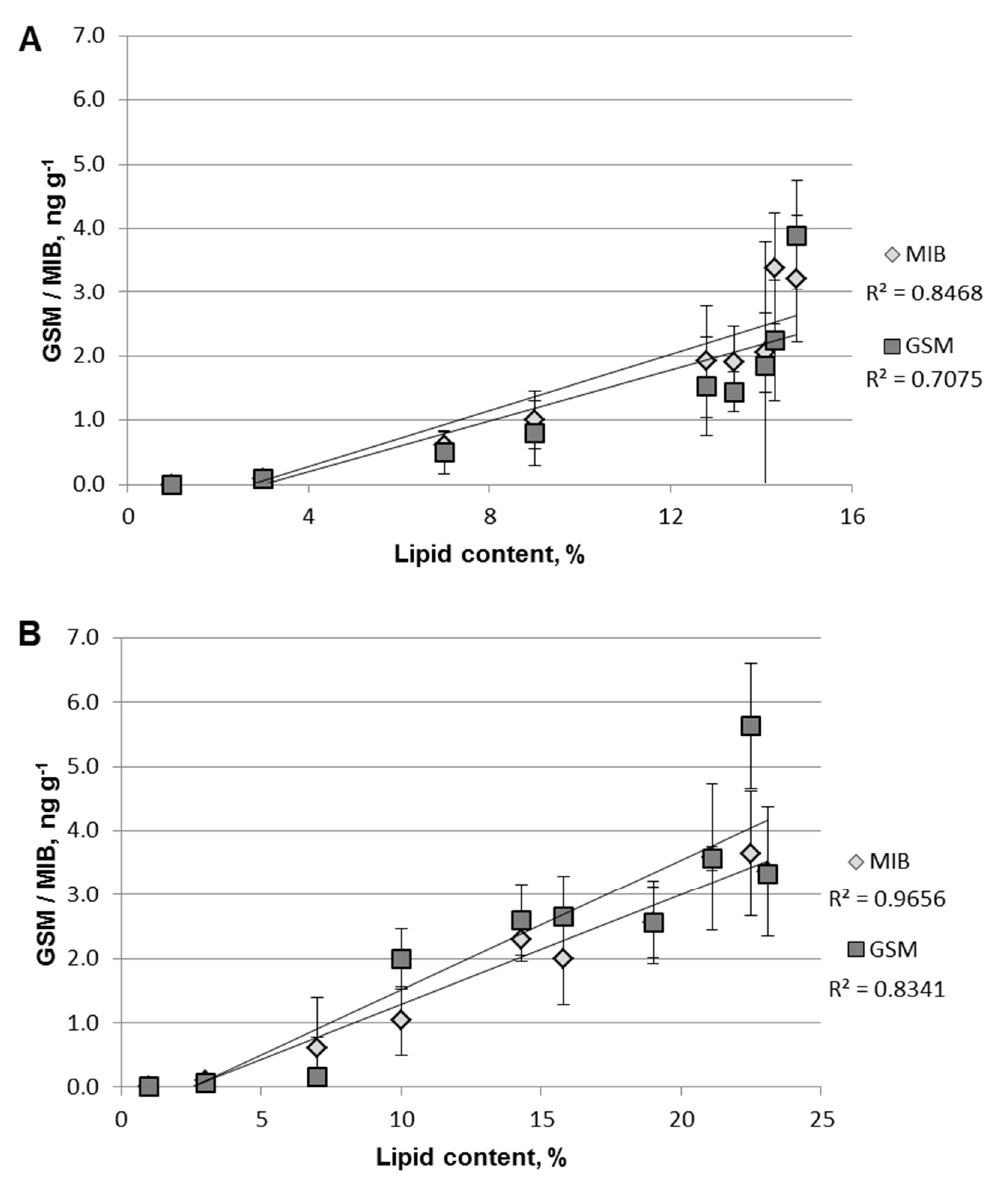
Figure 1. Concentrations of GSM and MIB (ng · g − 1 , n = 4, ± SD) in European whitefish ( A ) and in rainbow trout ( B ) vs. lipid content in fish fillet (%) during the experiment.